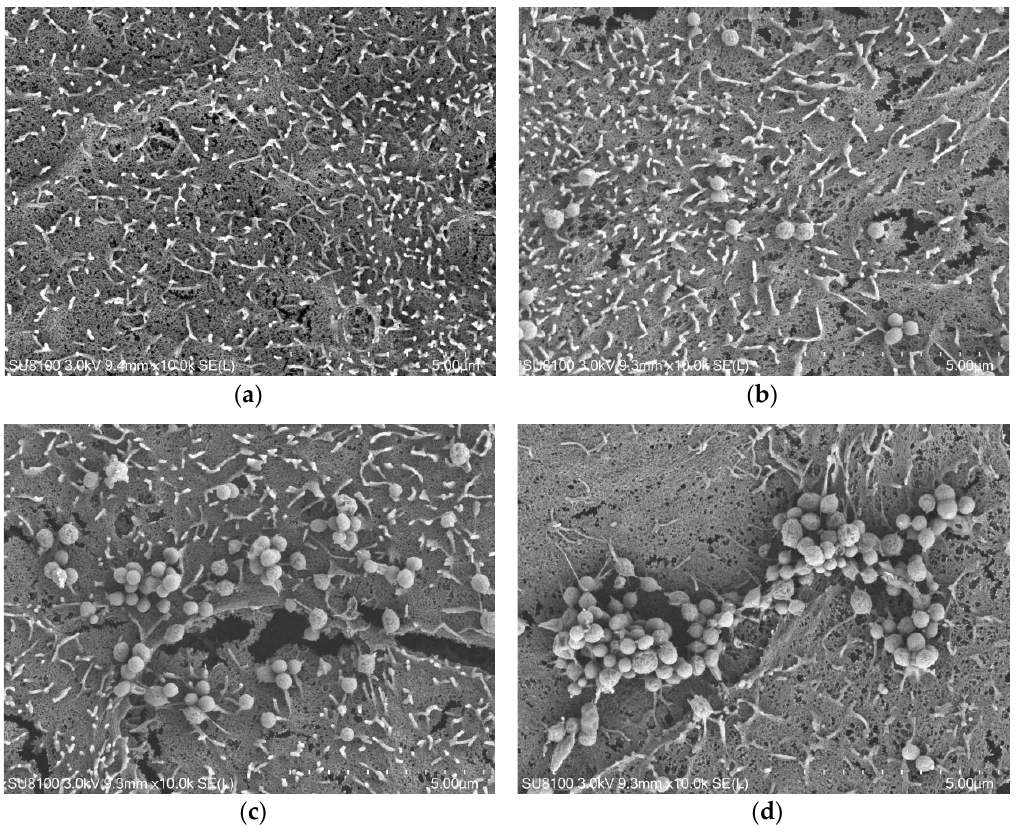
Figure 10. Scanning electron microscope observation on adhesion of E. faecalis to IPEC-J2 cells. ( a ) Blank control group; ( b ) Negative control group; ( c ) TGEV group; ( d ) TGF- β group.